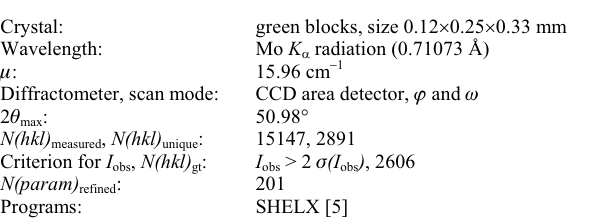
Table 1. Data collection and handling.